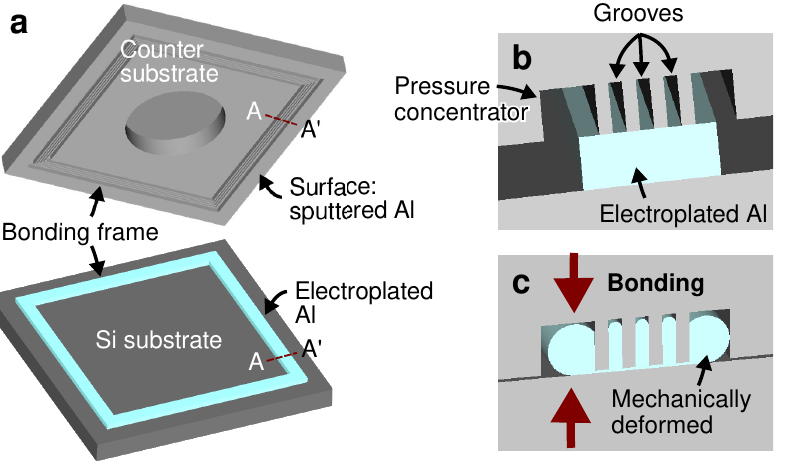
Figure 1. ( a ) Schematics of the test vehicle consisting of a Si substrate with electroplated Al and a counter substrate with grooves as the bonding frames. Enlarged schematics of the bonding interface cross-section A-A’ in-contact ( b ) before and ( c ) after the bonding